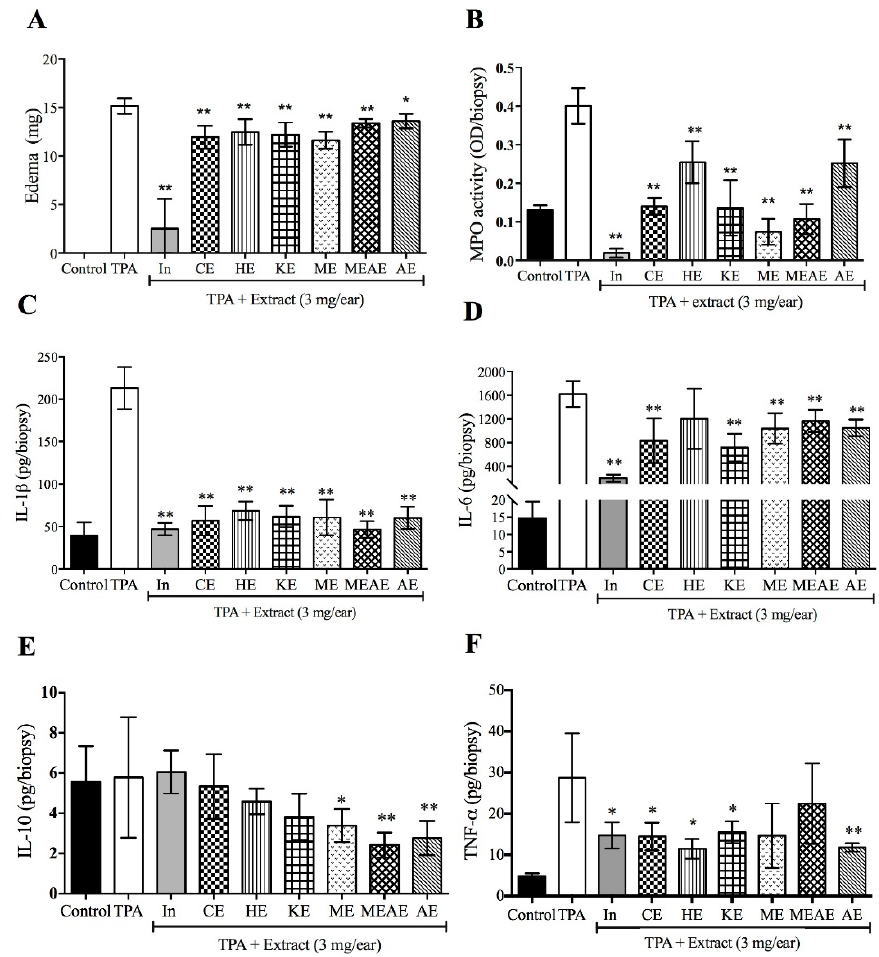
Figure 5. Effect of different extracts from Acacia farnesiana pods and the anti-inflammatory indomethacin (1 mg) on TPA-induced ear edema model. ( A ) ear edema measured at 4 h after TPA treatment and ( B ) oxidative enzyme myeloperoxidase (MPO) activity in supernatants of homogenates from TPA-treated ears. Levels of ( C ) interleukin-1 β ( D ), interleukin-6 ( E ), interleukin-10 and ( F ) TNF- α in supernatants of homogenates from ears after treatment with different extracts from AF pods. TPA = 12- O -tetradecanoylphorbol acetate; In = indomethacin; CE = chloroformic extract; HE = hexanic extract; KE = ketonic extract; ME = methanolic extract; MEAE = methanolic:aqueous extract and AE = aqueous extract. Each bar represents the mean ± standard deviation ( n = 6). * p < 0.05 and ** p < 0.001 with respect to TPA group.